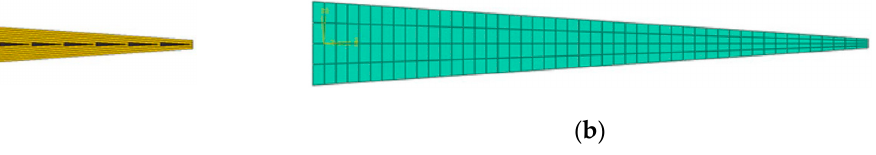
Figure 5. The comparison of a material beam between ( a ) the real FE model and ( b ) simple ply stack model. (Reprinted with permission from Ref. [14]. Copyright 2017 Hyoungsuk